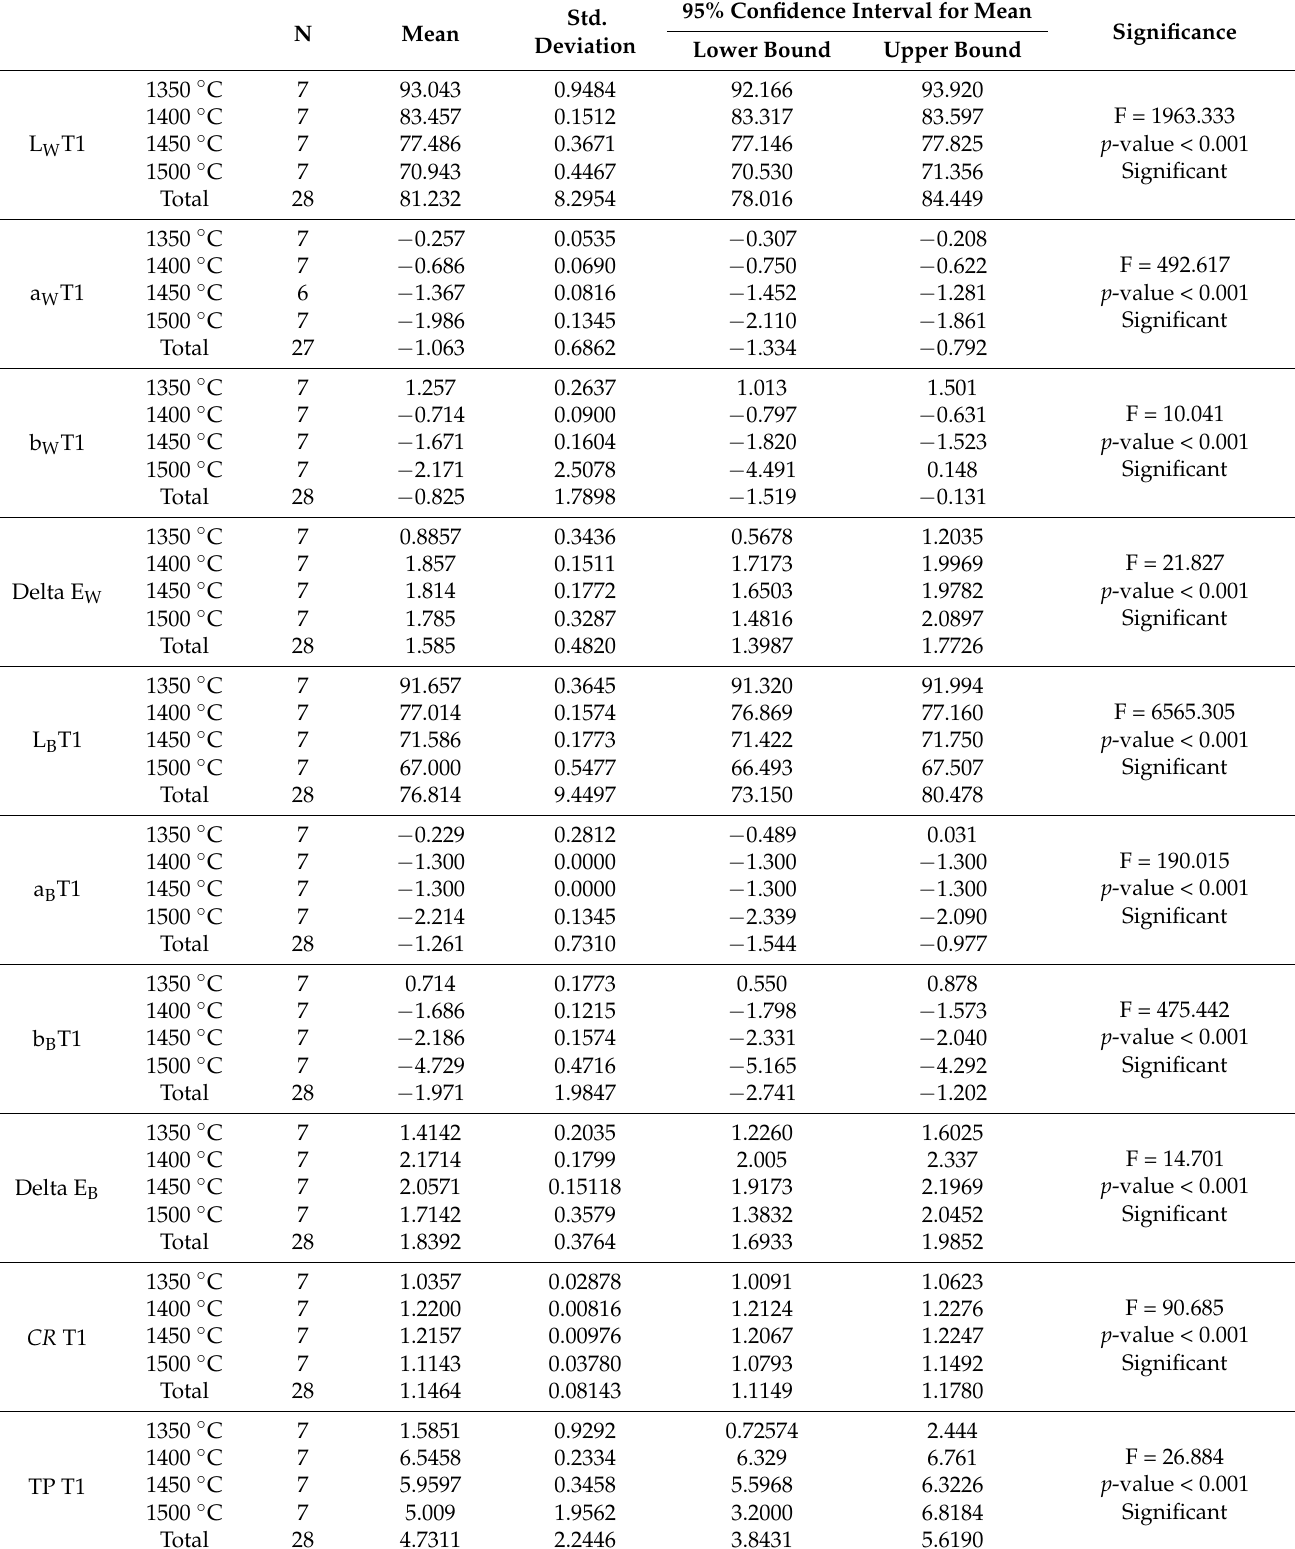
Table 3. Mean of color, translucency parameter (TP), contrast ratio ( CR ), and intergroup comparison between four groups after artificial